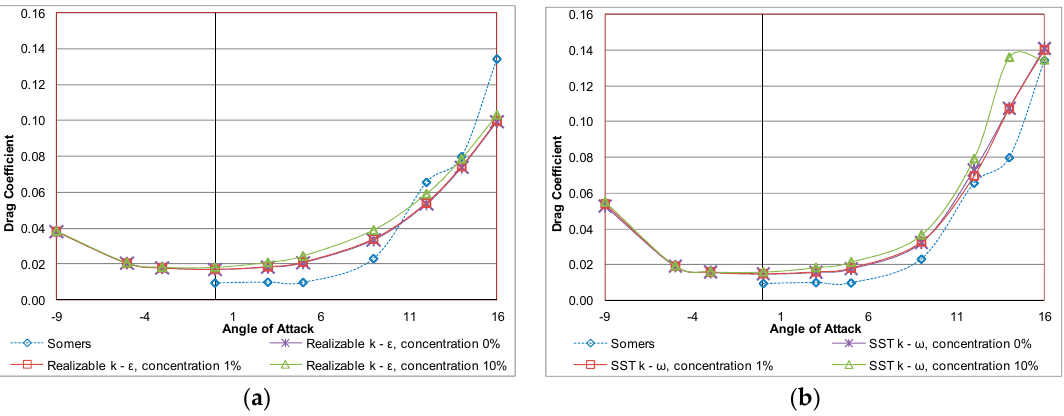
Figure 5. Comparison between reliable experimental data and simulation results of the drag coefficient curve for an S809 airfoil for ( a ) realizable k– ε ; and ( b ) SST k– ω turbulence models at Re = 1 × 10 6 for one-phase and two-phase flows consisting of two different concentrations of sand particles in the air.